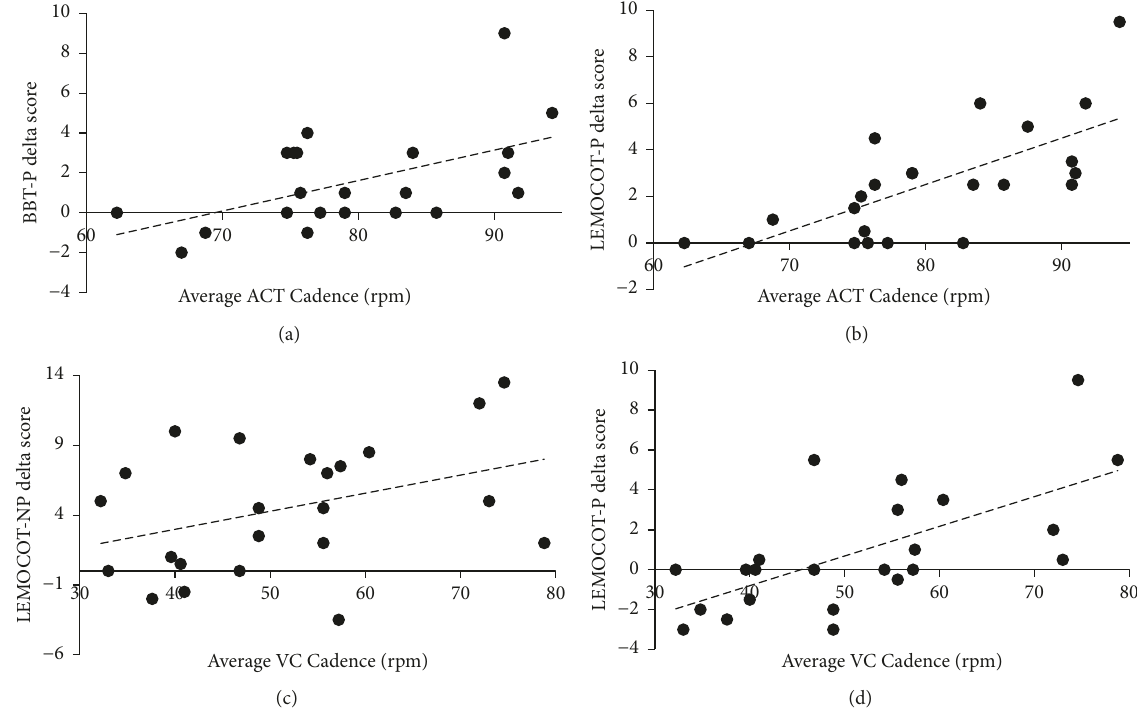
Figure 2: Significant positive linear trends (p < 0.05) between (a) BBT-P delta scores and cadence during ACT; (b) LEMOCOT-P delta scores and cadence during ACT; (c) LEMOCOT-NP delta scores and cadence during VC; (d) LEMOCOT-P delta scores and cadence during VC. Note: A positive delta score indicates improvement. The average ACT cadence is a weighted average of the first 5 minutes at a lower ACT cadence and the following 15 minutes at the ACT target cadence. ACT = Assisted Cycling Therapy; BBT-NP = Box and Blocks Test-non- paretic; BBT-P = Box and Blocks Test-paretic; LEMOCOT-NP = Lower Extremity Motor Coordination Test-non-paretic; LEMOCOT-P = Lower Extremity Motor Coordination Test-paretic; VC = voluntary